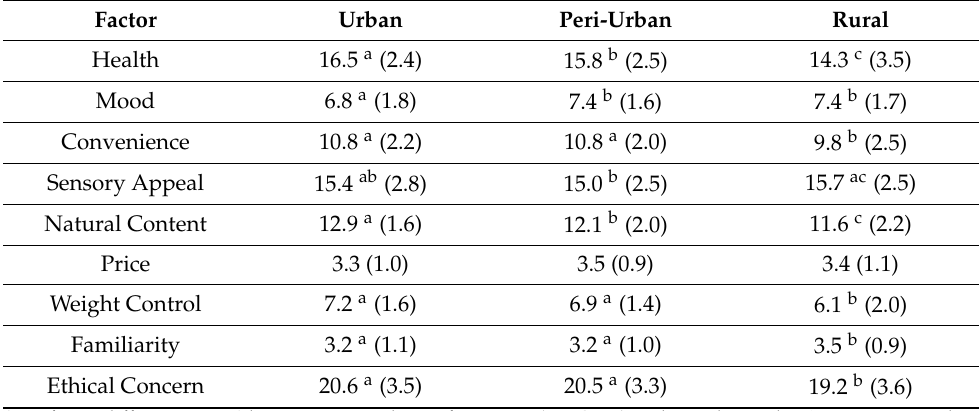
Table 2. Average food choices scores (standard deviation) by factor and